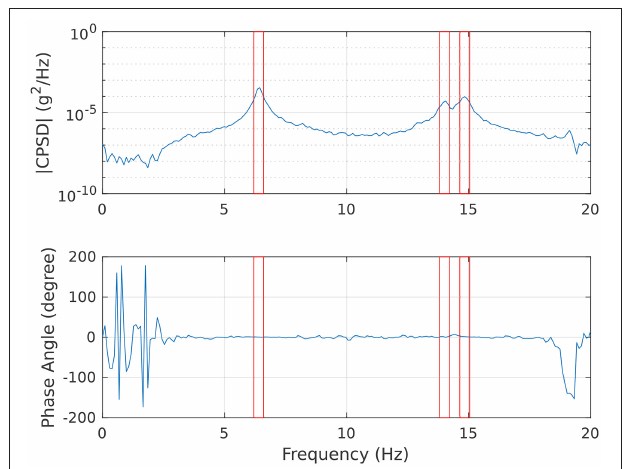
FIGURE 20 | Cross spectral density using Sensor #2 and #3.